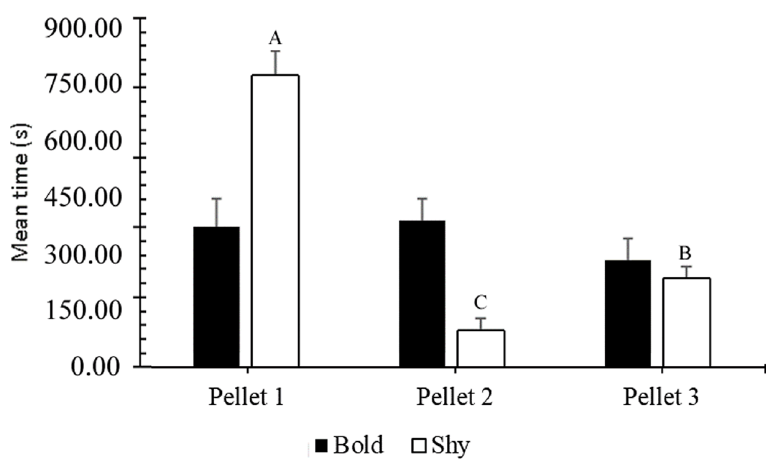
Figure 3. Mean values (± standard deviation) for consumption time among first, second and third pellets for Nile tilapia ( Oreochromis niloticus ) of different personalities. Different letters indicate significant differences between results by ANOVA followed by the Tukey test ( p <